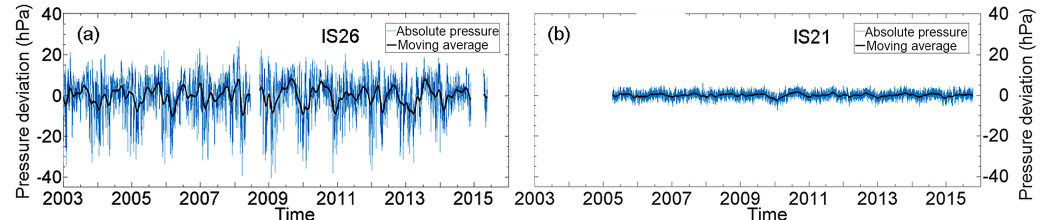
Figure 4. Absolute pressure data recordings of the IMS infrasound stations IS26 (a) and IS21 (b) as deviations from the annual means. The moving average highlights the superordinate annual variation.